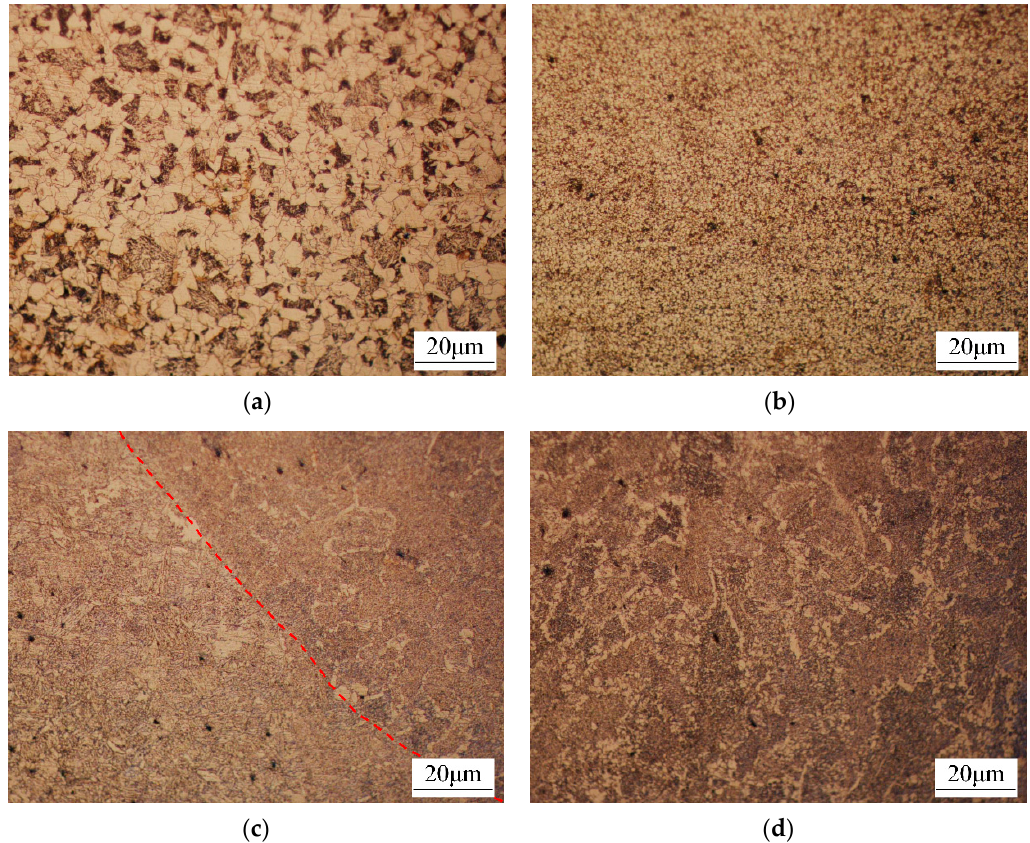
Figure 15. Microstructures of the 12Cr1MoV welded joint after DHT: ( a ) Base metal, ( b ) HAZ, ( c ) fusion zone, ( d ) weld metal.